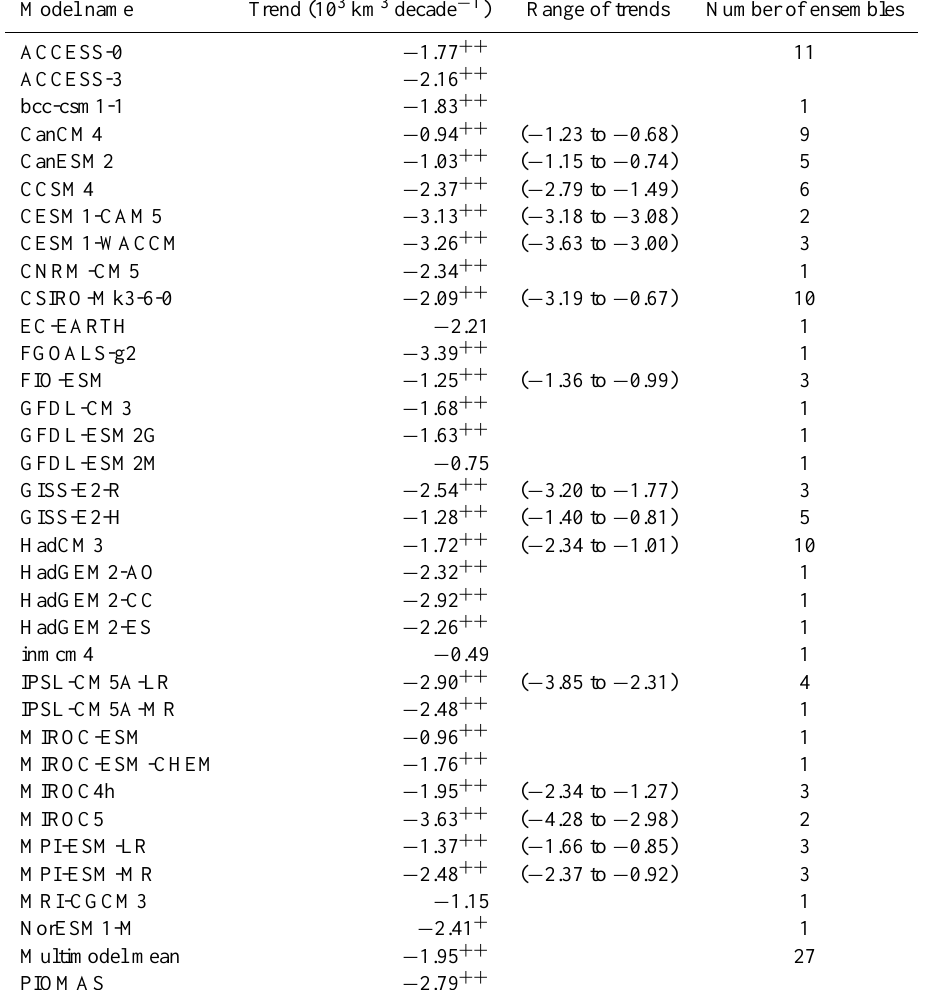
Table 4. Linear trends in Arctic sea ice volume for March based on the period 1979 to 2013 from 33 CMIP5 models and PIOMAS. For models with more than one ensemble member, the mean trend is given along with the range of the trend (in parenthesis). Trends are listed as km 3 per decade. Trends statistically different from 0 at 95 and 99% significance are denoted by + and ++ ,